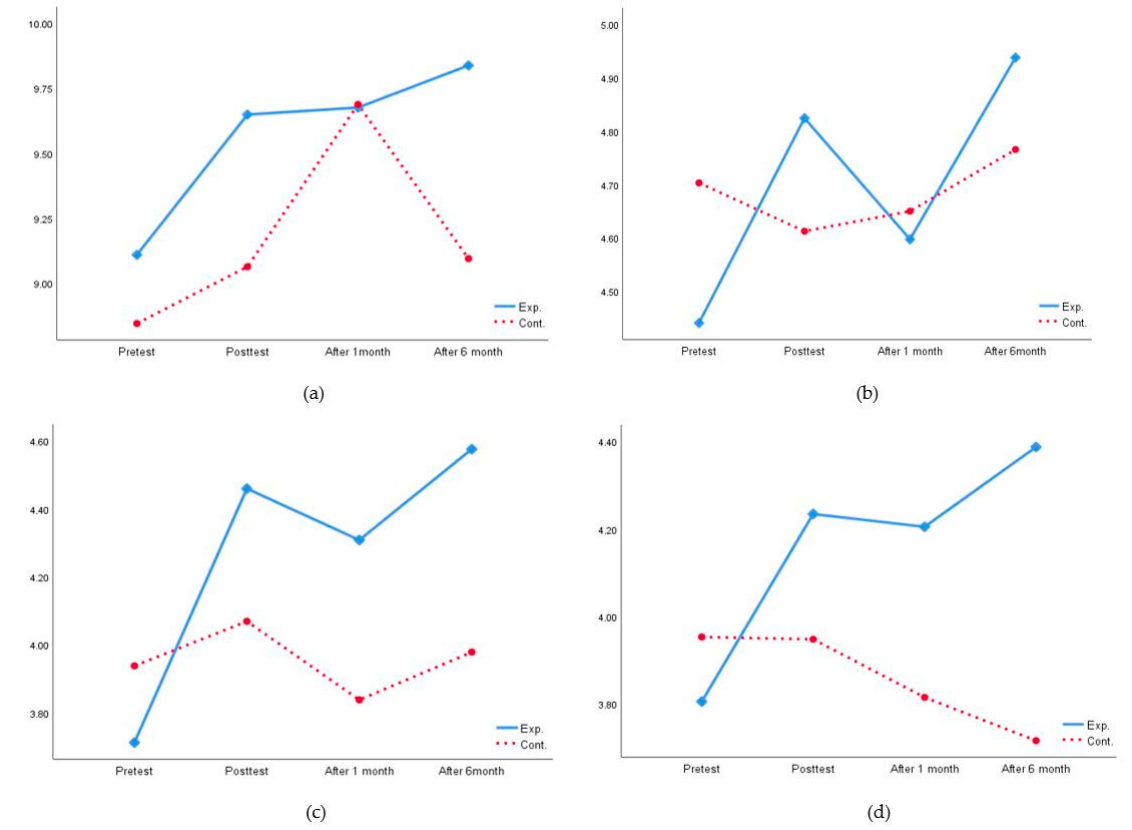
Figure 2. Interaction e ff ects between group and time on: ( a ) knowledge about RIP; ( b ) attitudes toward RIP; ( c ) RIP practices; ( d ) social capital.